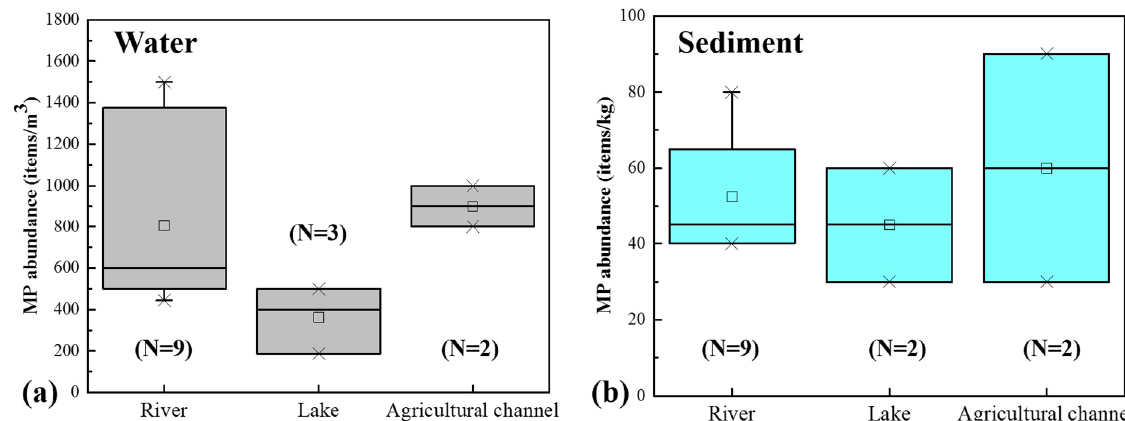
Figure 2. MP abundances within different environments. ( a ) MP abundances within different water bodies; ( b ) MP abundances within different sediments. (The little box represents the average value, and the horizontal line in the middle of the box represents the median.)